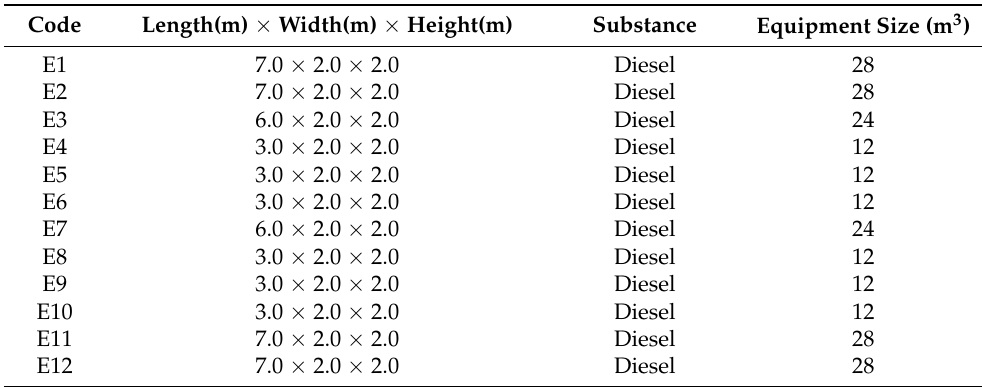
Table 2. Characteristics of engine room equipment.